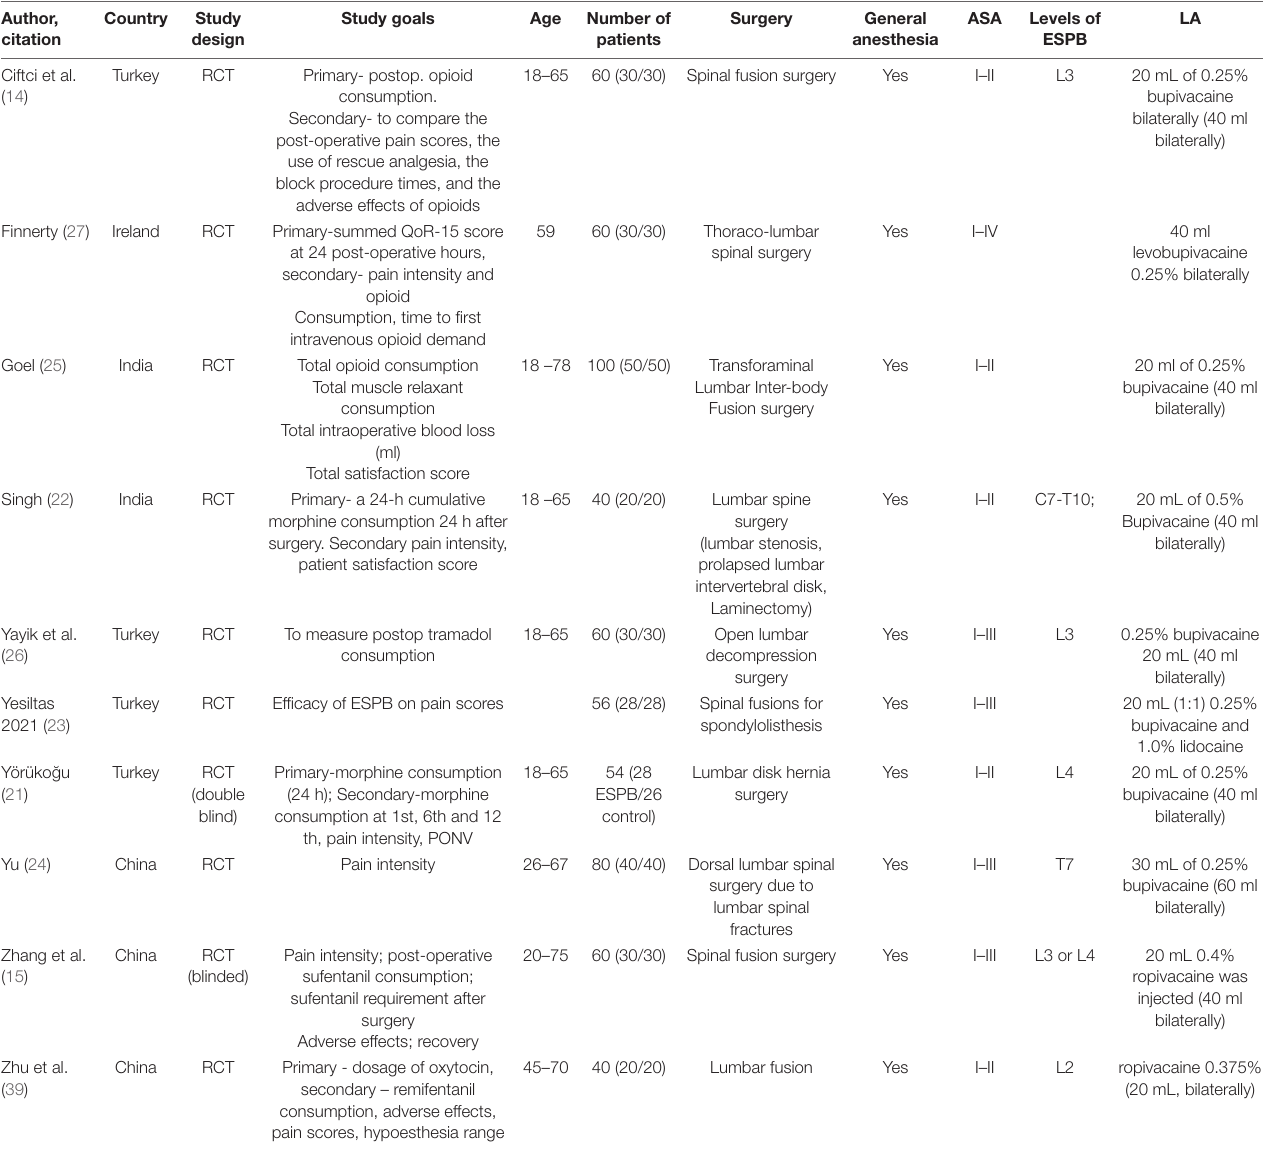
TABLE 1 | Characteristics of included